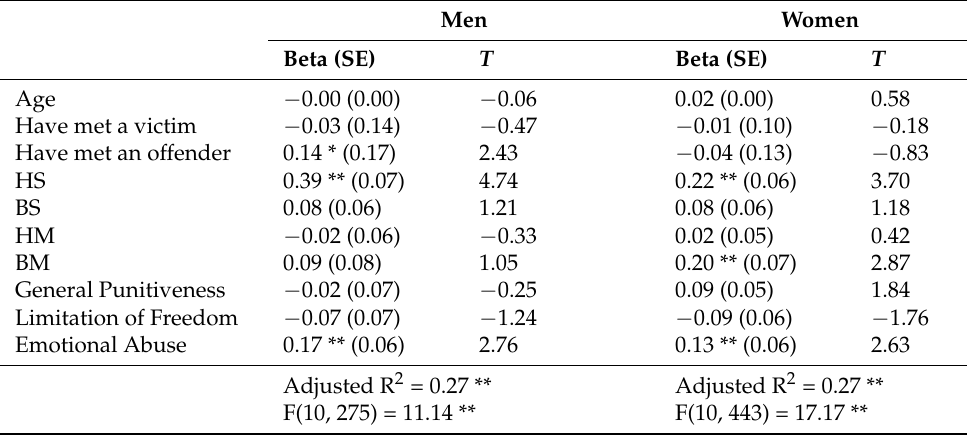
Table 4. Regression analyses predicting Stereotype Endorsement.